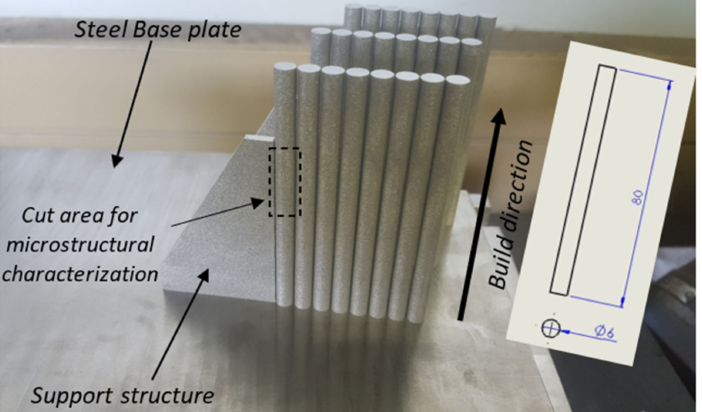
Figure 1. A photographic image showing the manufactured cylindrical rods of Ti6Al4V(ELI) on the EOS M280 machine platform. The insert schematic drawing shows the length of the rods in millimetres.